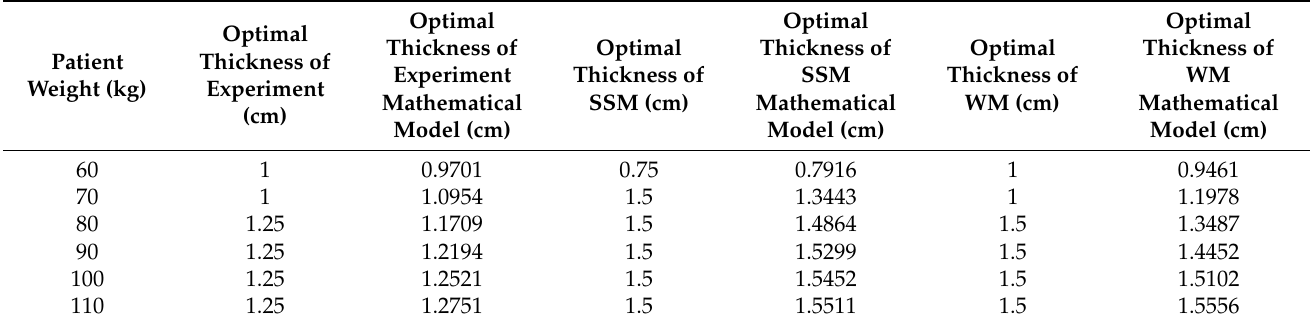
Table 5. Data on the relationship between different insole thicknesses and plantar pressures under human body weight in the